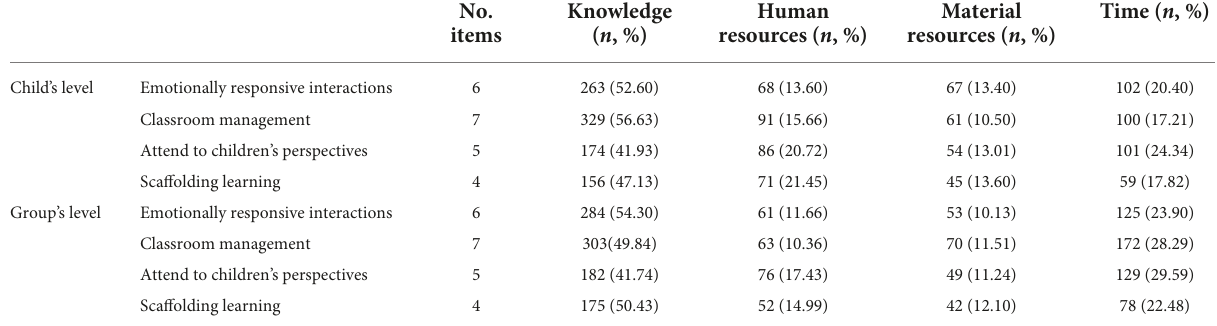
Human resources ( n ,